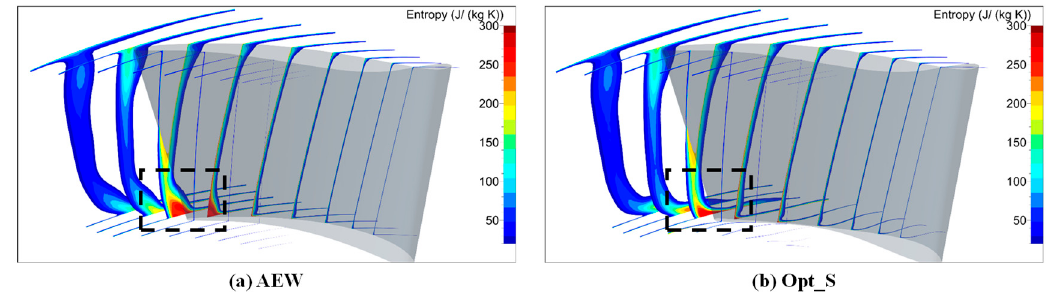
Figure 10. ( a , b ) Entropy contours at equidistant cutting planes in a stator row.